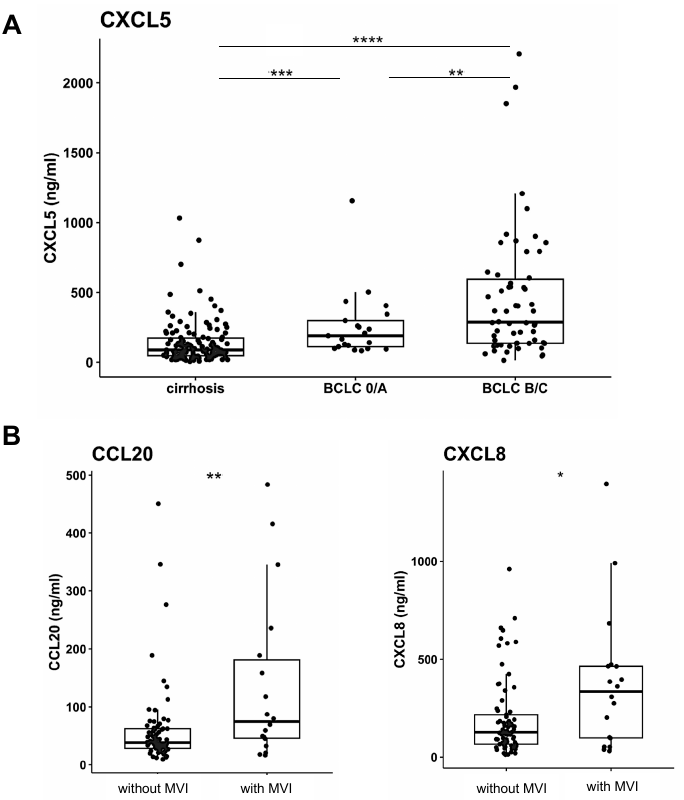
Figure 2. Inflammatory chemokine serum levels in patients with cirrhosis and with early or advanced HCC. Scatter dot plots with horizontal bars indicating median and IQR (* p ≤ 0.05, ** p ≤ 0.01, *** p ≤ 0.001, **** p ≤ 0.0001). ( A ) CXCL5 was significantly upregulated in patients with advanced HCC compared to early HCC and patients with cirrhosis but without HCC. ( B ) CCL20 and CXCL8 were significantly elevated in HCC patients with MVI compared to HCC patients without